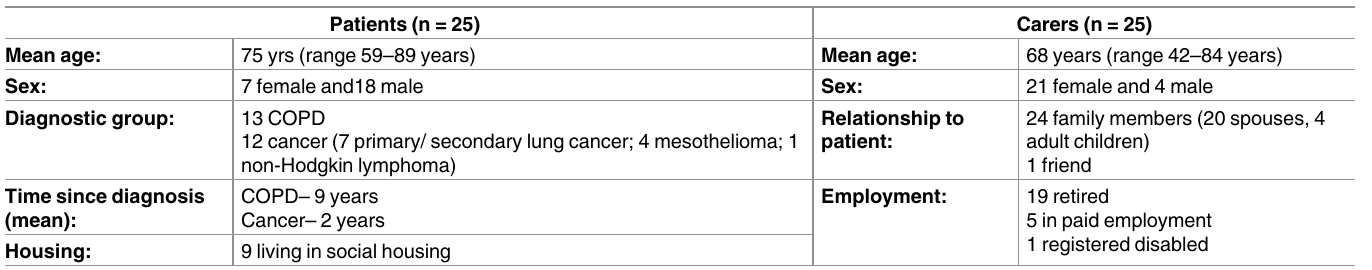
Table 2. Characteristics of participating patients and